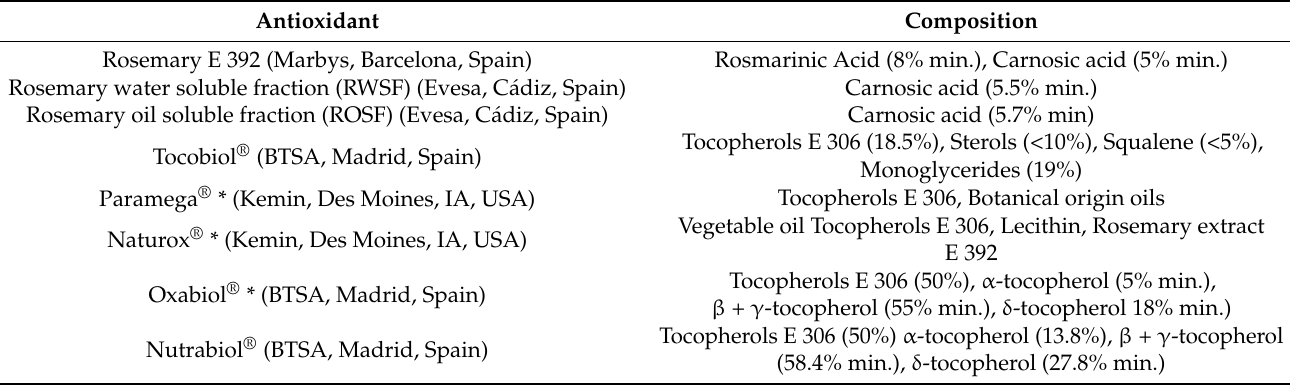
Table 1. Composition of the different products whose antioxidant capacity was